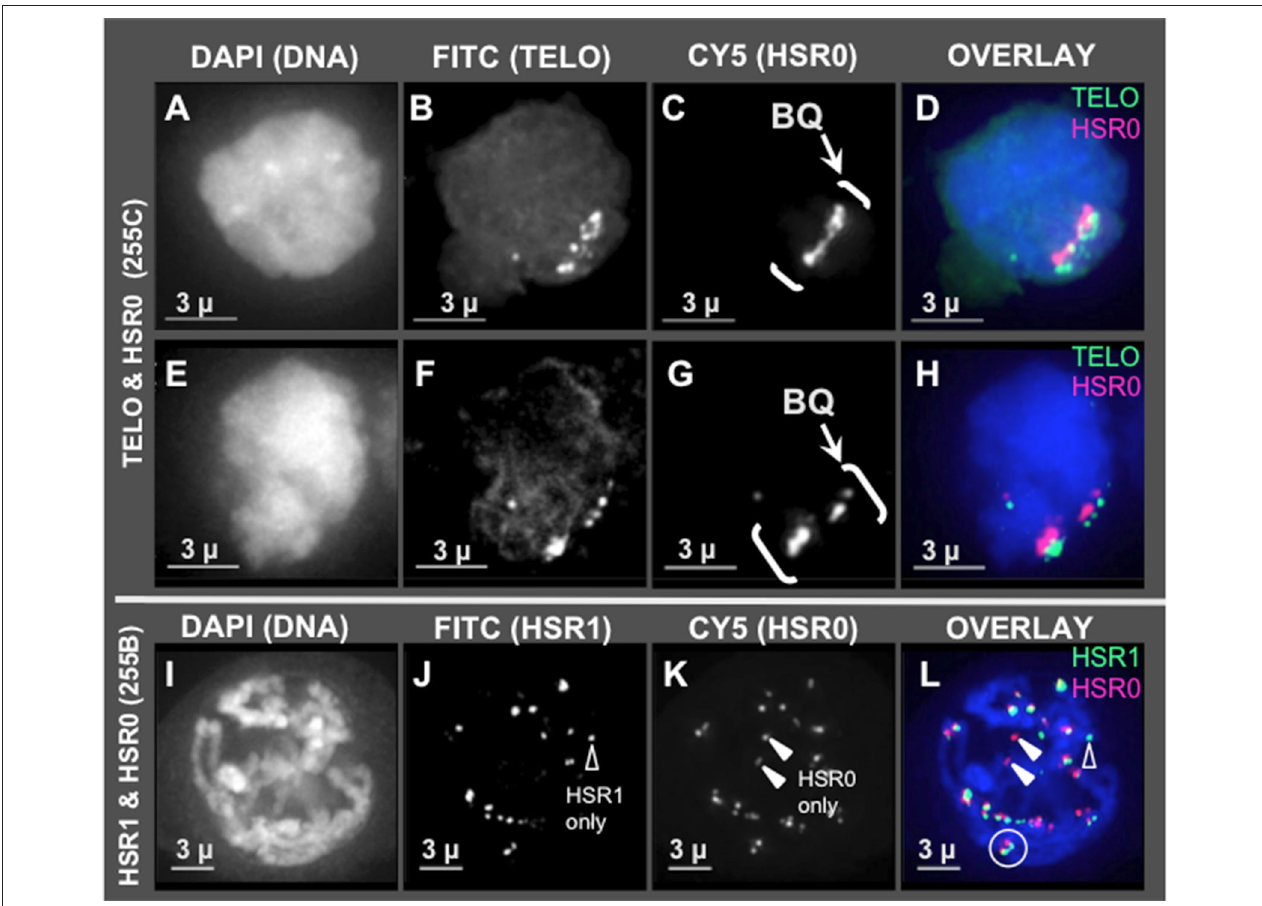
FIGURE 3 | HSR0 co-localization with telomere and HSR1. Projections of 3D FISH datasets were produced as described in Figure 1 with an additional probe, HSR0. (A–D,E–H) Two hop nuclei from plant 255C at early prophase showing telomeres and HSR0 FISH signals clustered in one area on the nuclear periphery, the bouquet (bracketed, BQ). (I–L) One hop nucleus from plant 255B at middle-late prophase, homologous chromosomes paired in diplotene showing HSR0 and HSR1 co-localizing at the ends of chromosomes. (J) Showing HSR1 signal not co-localized (open arrowhead) and (K) showing two HSR0 signals not co-localized (closed arrowheads). (L) Circle denotes clear example of co-localization and polarity of the two FISH signals at the ends of chromosomes. Open and closed arrowheads show HSR1 and HSR0 signals, respectively, not co-localized. The length of the scale bars (3 microns) is